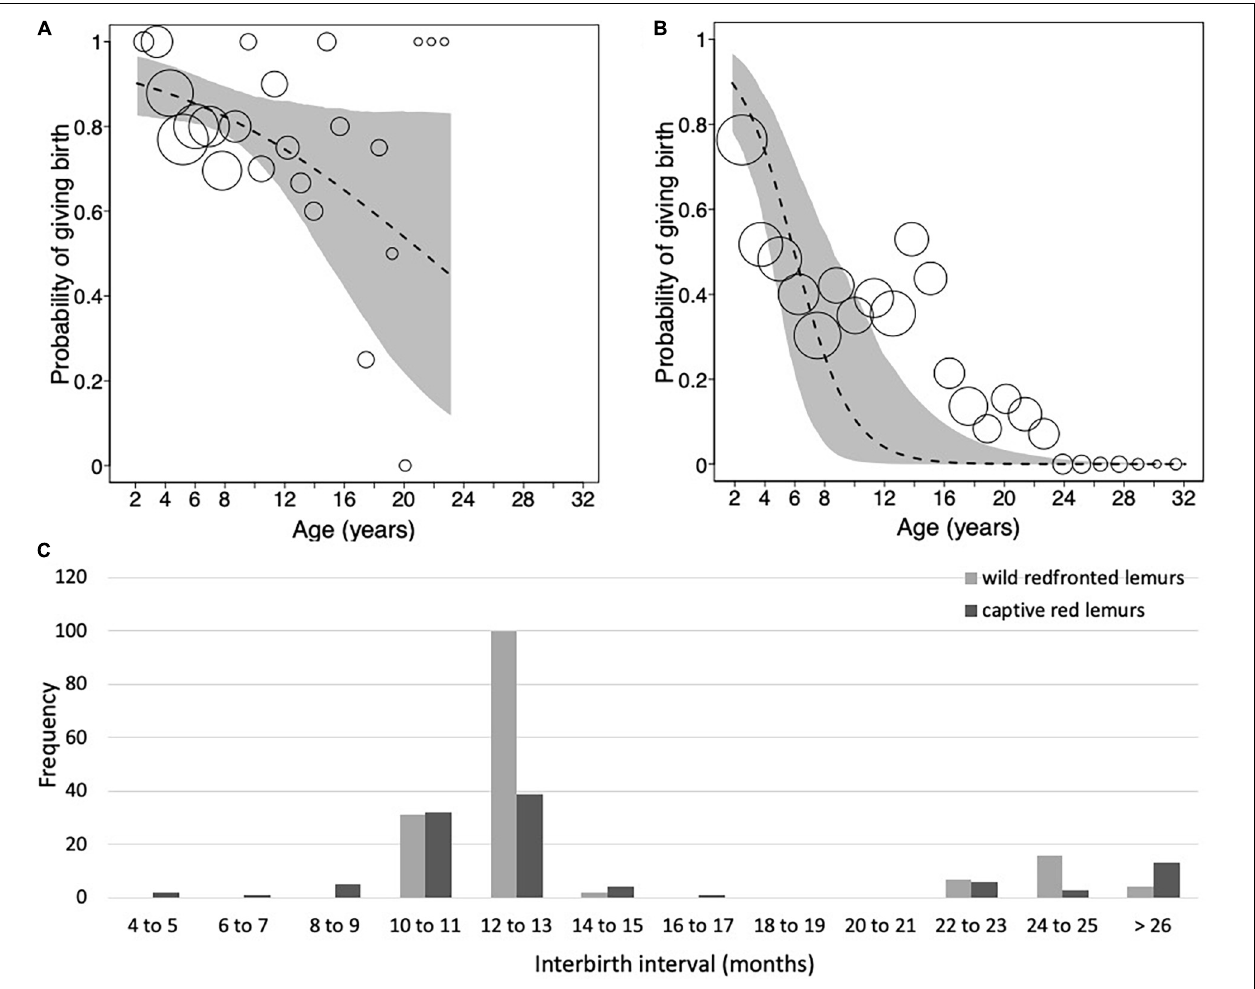
FIGURE 4 | Probability of giving birth as a function of mother’s age for (A) wild redfronted lemur and (B) captive red lemur. (C) Frequency distribution of interbirth intervals of wild redfronted lemurs (light gray; N = 132) and captive red lemurs (dark gray; N = 103). Dashed lines represent the regression lines, gray polygons represent the 95% confidence intervals, and dots represent the number of observations with the area of dots being proportionate to the number of observations per binned age (redfronted lemurs: range 2–23, red lemurs: 2–26). Note that the dots in panels (A,B) are not to the same scale.